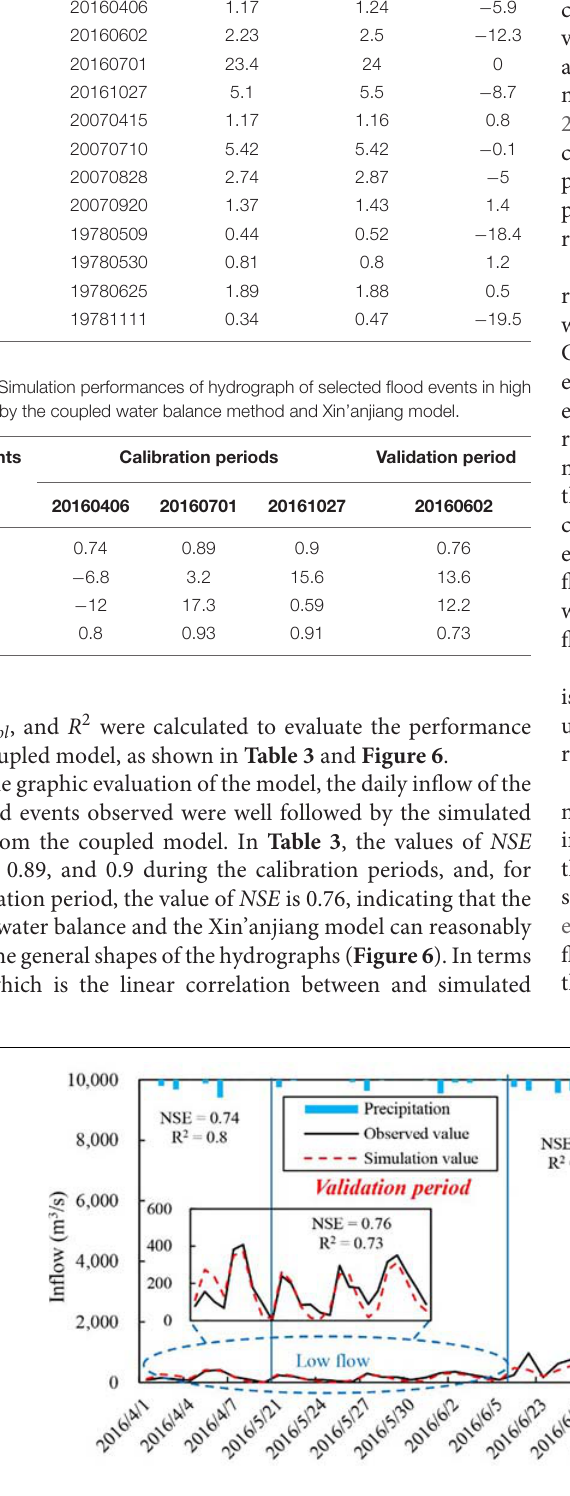
FIGURE 6 | Results for the four flood events of Lake